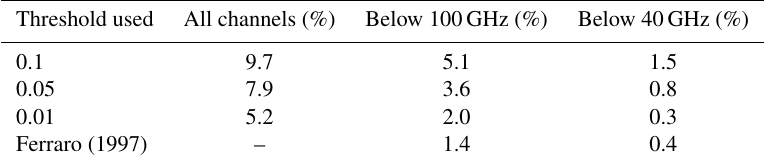
Table 6. Percentage of MW observations classified as cloud contaminated for the three MW frequencies ranges, with different thresholds on the NN classifier output. Results are presented for 15 June 2015 over land surfaces within the SEVIRI disk. The last line of the table presents the percentage of observations detected as precipitating with the Ferraro method using channels up to 100GHz or only below